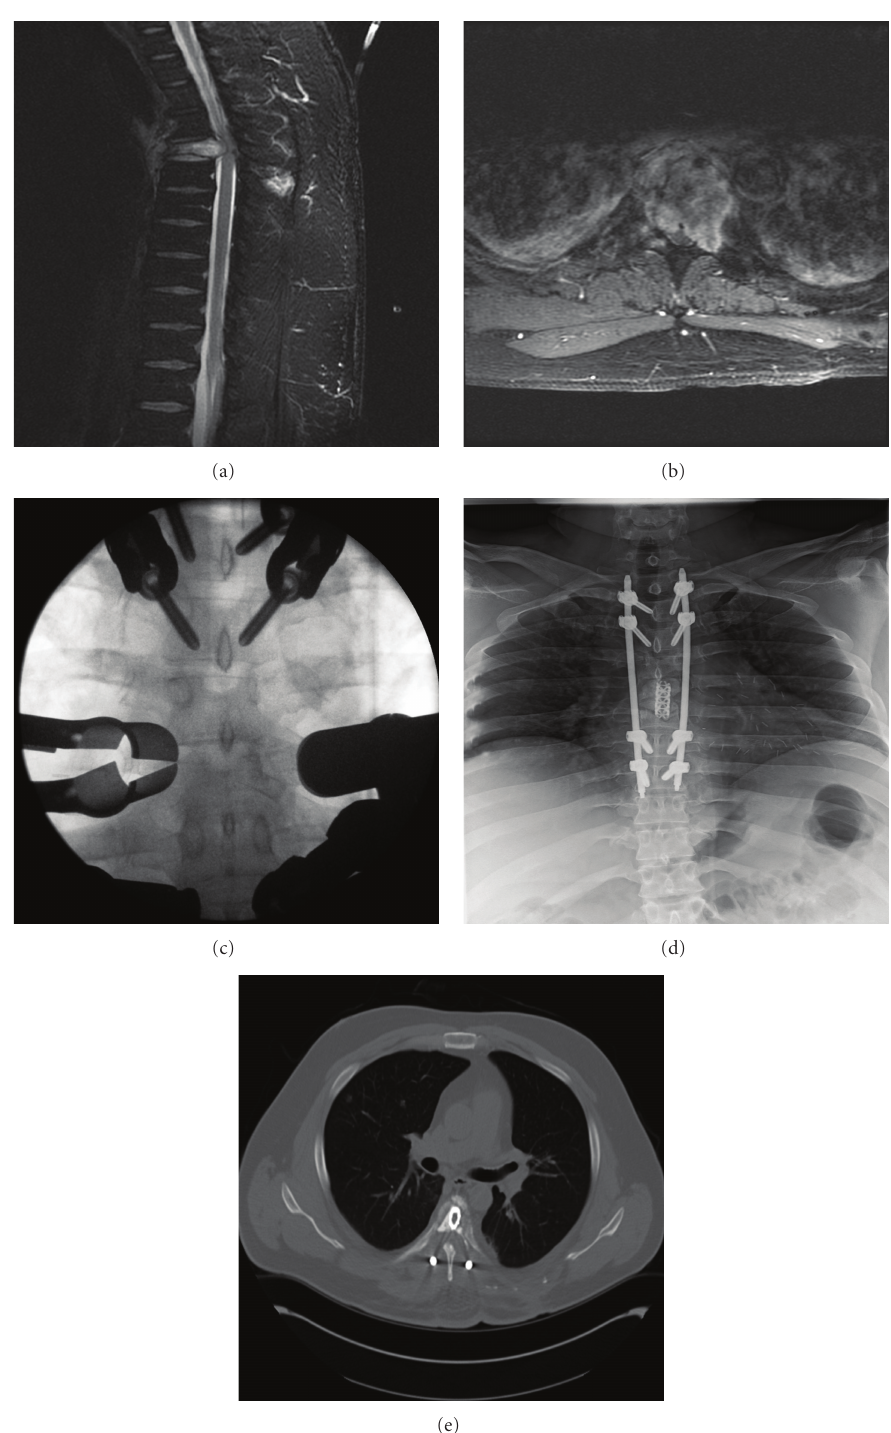
Figure 5: Bilateral extracavitary decompression for metastatic fibrosarcoma. (a) Sagittal T2-weighted, and (b) axial gadolinium enhanced MR images demonstrate pathologic fracture and metastatic epidural spinal cord compression at T5. (c) Fluoroscopy demonstrating docking of extracavitary retractors over the T5 costovertebral region. (d) Postoperate radiograph demonstrating T2–T8 fixation with cage + methylmethacrylate reconstruction of T5. (e) Postoperative CT demonstrates bilateral extracavitary decompression with cage/cement